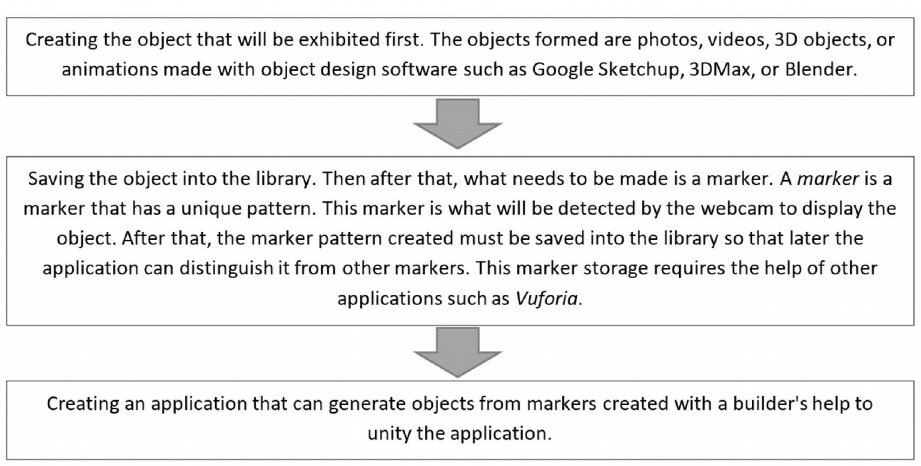
Figure 6. The specific steps in developing AR (Suprapto & Nandyansah,